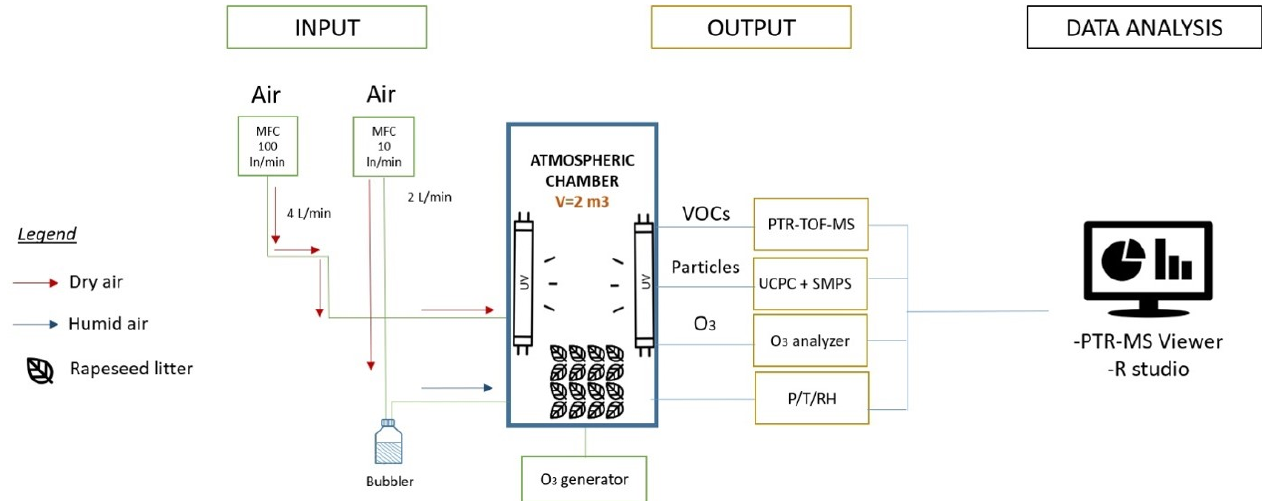
Figure 2. Scheme of the multiphase reaction chamber used for the study of the photoreactivity of the VOCs emitted from senescence rapeseed. The PTR-TOF-MS has been used for the VOCs detection; the ultrafine condensation particle counter (UCPC) and the SMPS have been used for the detection of the particle formation and measurement of the particle sizes respectively; and the O 3 analyser detected the ozone inside the chamber, where P (pressure), T (temperature), and RH (relative humidity) have been constantly monitored during the entire